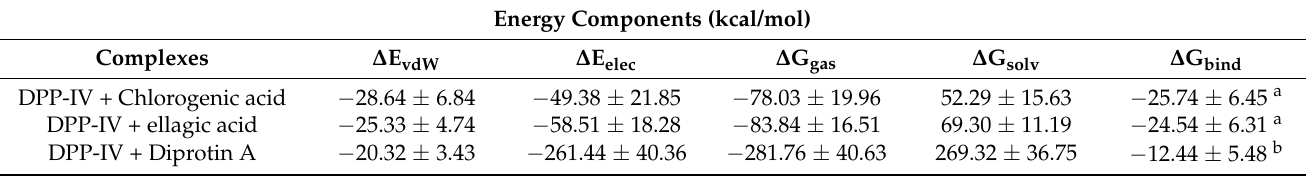
Table 2. Energy components analyses of the molecular dynamics simulation of the compounds.